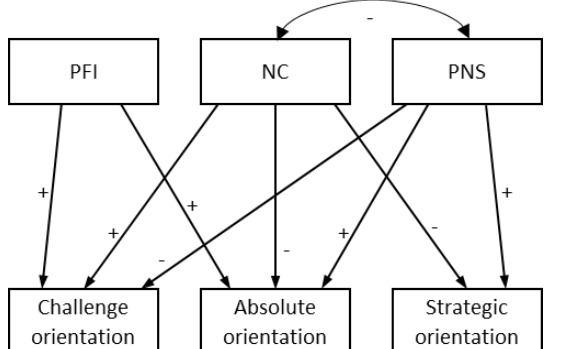
Figure 5. A conceptual framework of the hypothesised relationships between Personal Need for Structure, Need for Cognition, Personal Fear of Invalidity and Strategic, Absolute and Challenge orientation in the processing of CBA